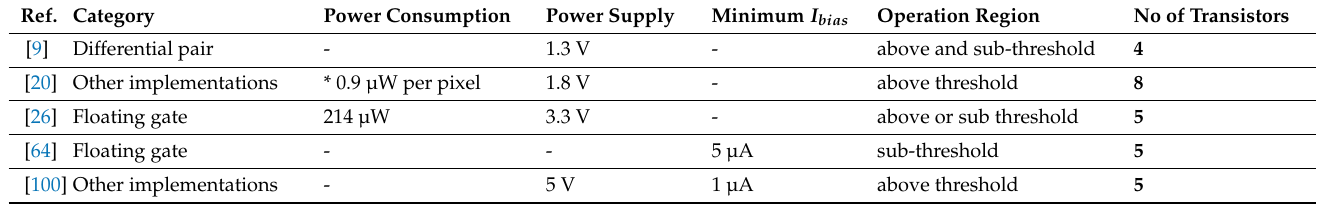
Table 12. Gaussian Function Circuits performance summary and comparison. * Power consumption for the entire System. Ref. Category